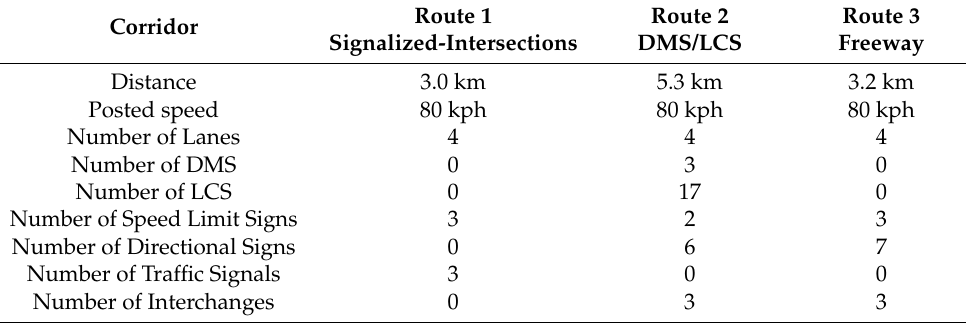
Table 2. Characteristics of the study corridors.